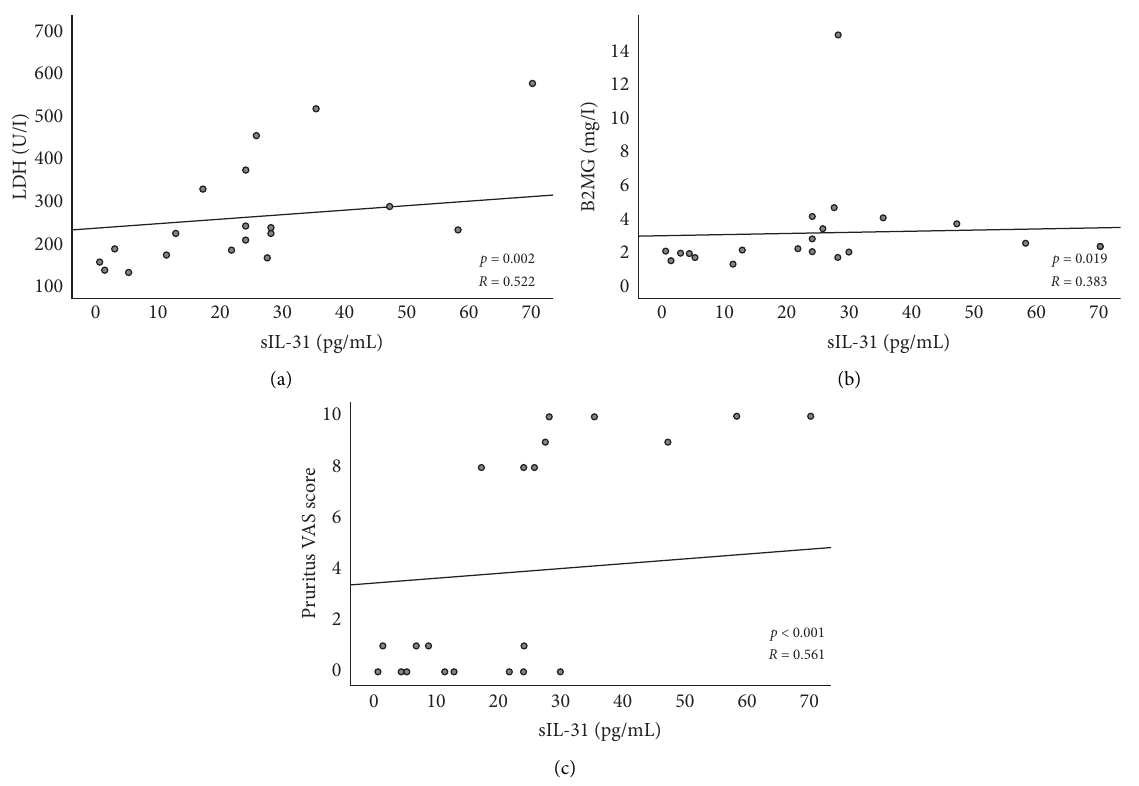
Figure 2: Correlations between IL-31 serum levels and LDH serum levels (a), B2MG serum levels (b), and itch VAS score (c). In this figure, 2 outliers were excluded for correlations involving sIL-31 (sIL-31 > 200pg/mL), and the p and R values presented refer to analysis excluding outliers. Sta- tistical analysis was performed using Kendall’s tau-B correlation coefficient. Statistics (including/excluding the outliers): sIL-31 vs . LDH: p � 0 . 001; R = 0.545/ p � 0 . 002; R = 0.522; sIL-31 vs . B2M: p � 0 . 009; R = 0.406/ p � 0 . 019; R = 0.383; sIL-31 vs . SC count: p � 0 . 008; R = 0.406/ p � 0 . 012; R = 0.423; and sIL-31 vs . pruritus VAS score: p < 0 . 001; R = 0.530/ p < 0 . 001; R = 0.561. B2M, beta 2 microglobulin; CTCL, cutaneous T-cell lymphoma; IL, interleukin; LDH, lactate dehydrogenase; SC, S´ezary cells; and sIL-31, interleukin-31 serum levels.